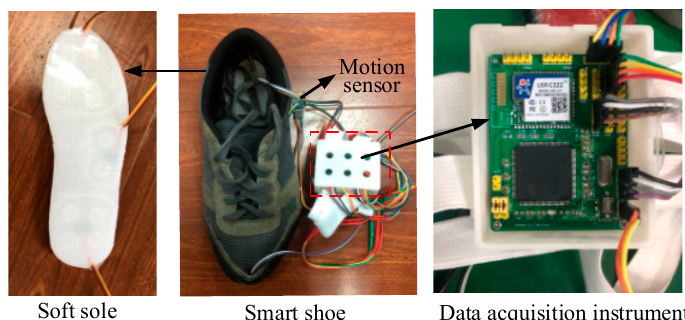
Figure 1. Wearable smart shoe.